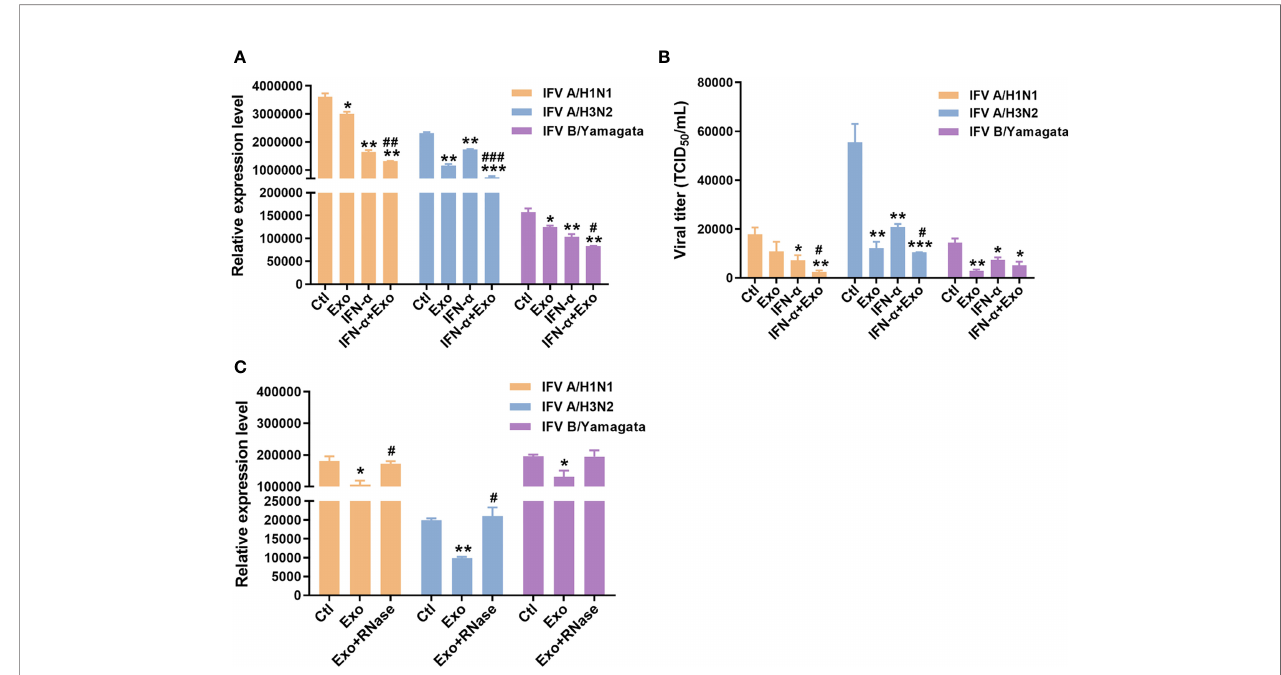
FIGURE 2 | U-exo treatment reduces IFV replication and shows a synergistic antiviral effect with IFN- a on IFV infection. (A) A549 cells were infected with IFV A/ H1N1, IFV A/H3N2 and IFV B/Yamagata at an MOI of 1. After viral attachment, cells were treated with control (Ctl), U-exo (Exo), IFN- a (10 ng/mL), or IFN- a combined with U-exo (IFN- a +Exo) for 48 h, after which viral gene expression levels were measured using RT-qPCR. Expression levels of the viral nucleoprotein ( NP ) for IFV A/H1N1 or H3N2 or matrix protein 1 ( M1 ) for IFV B/Yamagata were quanti fi ed and normalized against GAPDH . Data are shown as the mean ± standard deviation (SD) of the means from three independent experiments. (B) Viral titers were measured using the TCID 50 assay and expressed as TCID 50 /mL (means ± SD; n = 3). Statistical analysis: *p < 0.05; **p < 0.01; ***p < 0.001, versus Ctl-treated cells. # p < 0.05; ## p < 0.01; ### p < 0.001, versus IFN- a -treated cells. (C) A549 cells were infected with IFV A/H1N1, IFV A/H3N2 and IFV B/Yamagata at an MOI of 1. U-exo were exposed to 1 m g/mL RNase for 1 h and added to IFV-infected cells. Viral gene expression levels were measured (means ± SD; n = 3). Statistical analysis: *p < 0.05; **p < 0.01; versus Ctl-treated cells. # p < 0.05, versus U-exo (Exo)- treated